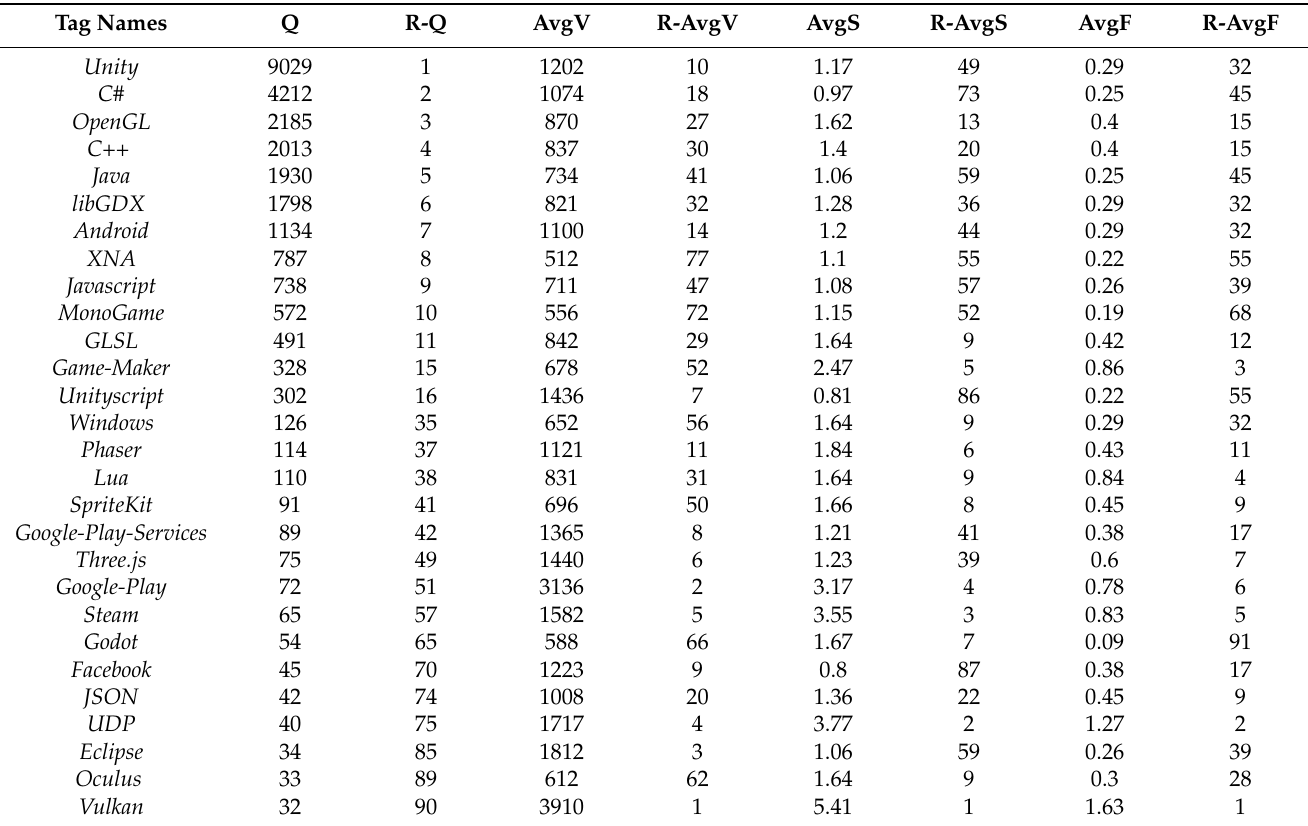
Table 2. Top 10 tech tags for all the considered